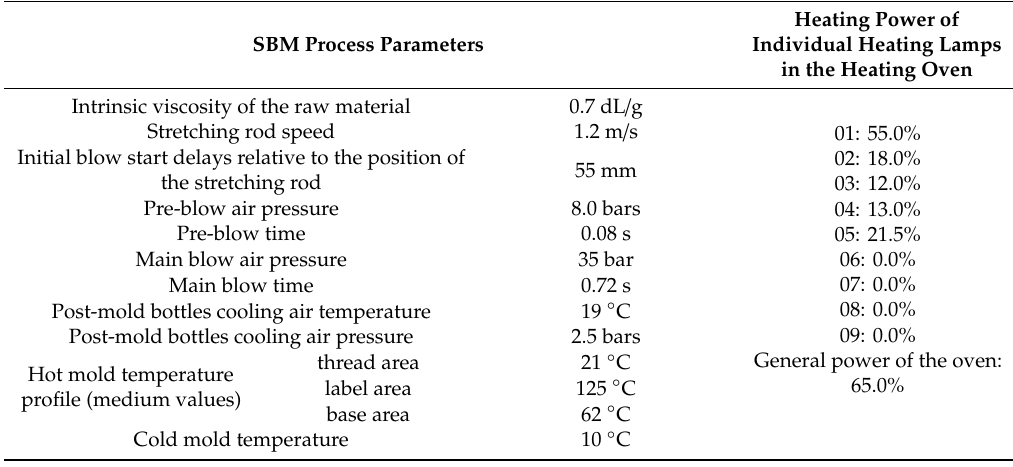
Table 2. The stretch blow moulding (SBM) process parameter values not subject to testing.